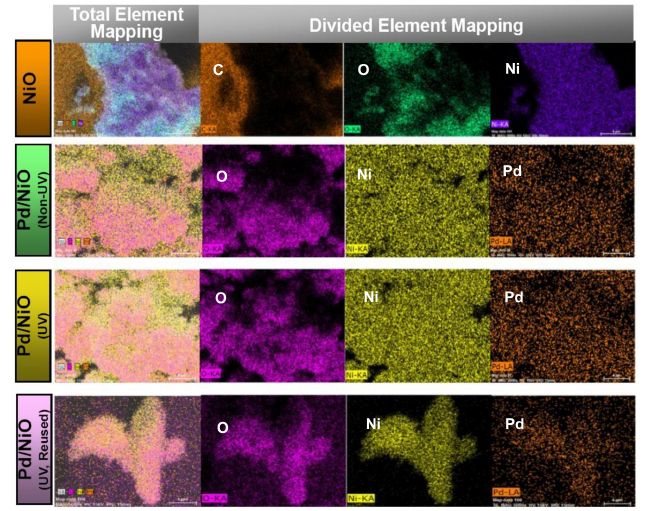
Figure 4. Element mapping of all samples including NiO carrier and Pd-based catalysts. Carbon element mapping indicates carbon conduction